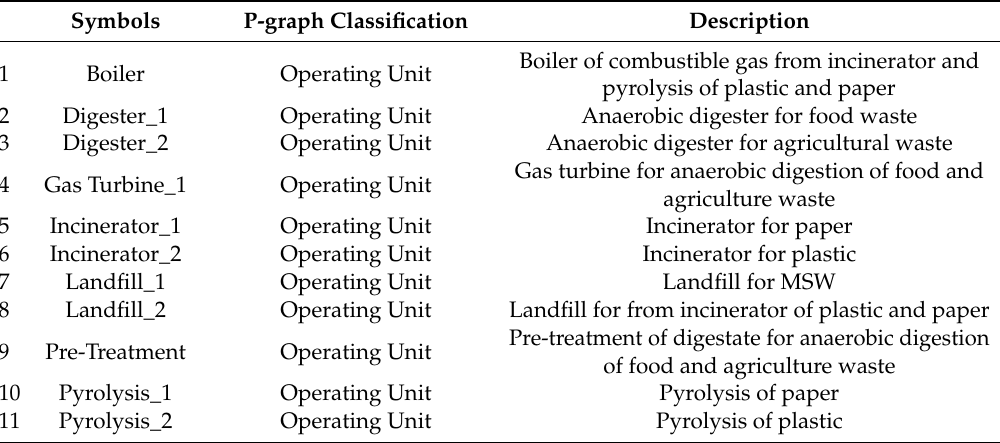
Table 3. List of operating units for the P-graph.